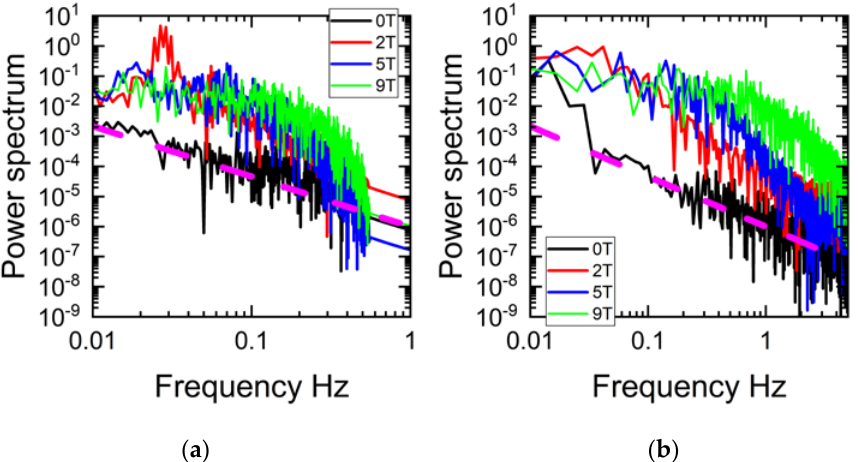
Figure 8. Power spectrum of the temperature for the case with Δ T = 5 °C ( a ) experimental and ( b ) numerical.